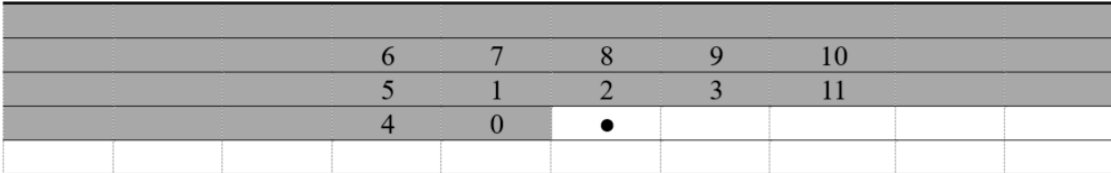
Figure 2. Illustration of the search order.